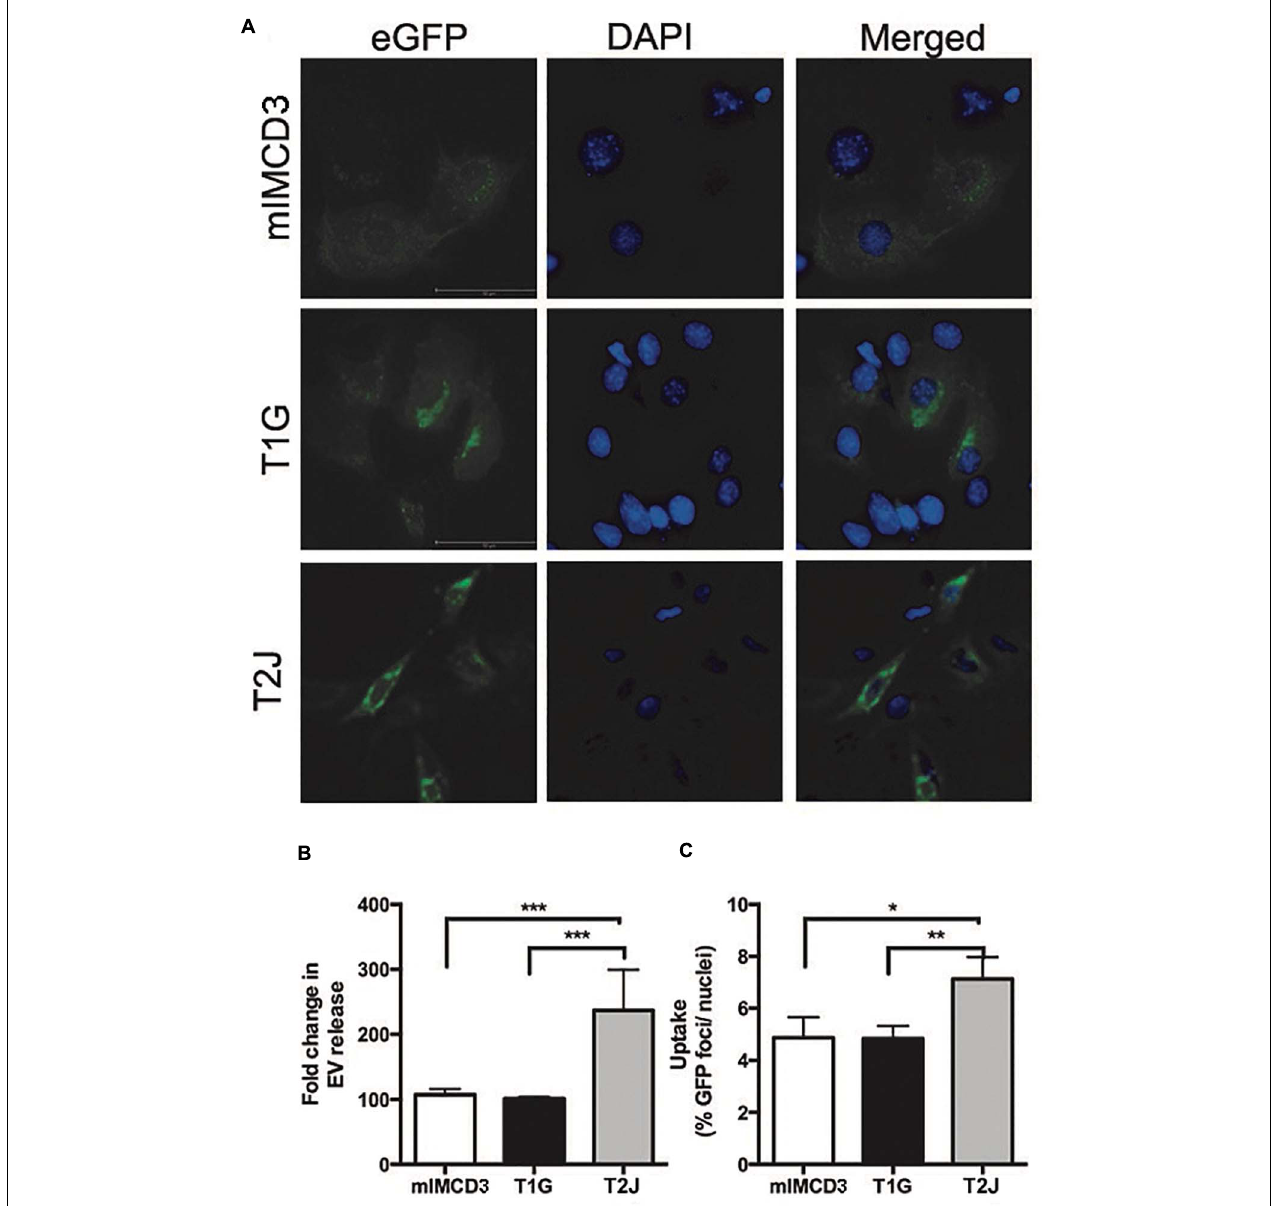
FIGURE 3 | Release and uptake of extracellular vesicles. mIMCD3, T1G, and T2J cells were transfected with green fluorescent protein (eGFP)-tagged CD63, a marker of extracellular vesicles (EVs). (A) Immunofluorescence images of eGFP-transfected mIMCD3, T1G, and T2J cells with blue nuclear DAPI stain. (B) Fold difference in release in reference to mIMCD3 EV-release ( n = 4) and (C) uptake of EVs from mIMCD3 (reference), T1G, and T2J cells. Cells were transfected with eGFP-CD63 plasmid. After 48 h, transfection media were collected, and cells were lysed. Mean fluorescence intensities (MFIs) normalized to protein content were quantified in cell media (to measure EV release). For uptake of GFP-positive EVs by intercalated M1 cell - EVs isolated from the culture media of mIMCD3, T1G, and T2J cells were used to treat M1 cells at a dose of 50 million EVs/ml in a microscopic slide chamber for 24 h. Slides were imaged, and the number of GFP positive foci was counted and normalized to the number of DAPI-positive nuclei. Mean ± SD data of total of 15–20 images were analyzed from two experiments. Student’s t -test was performed (* p < 0.05, ** p < 0.01, *** p <